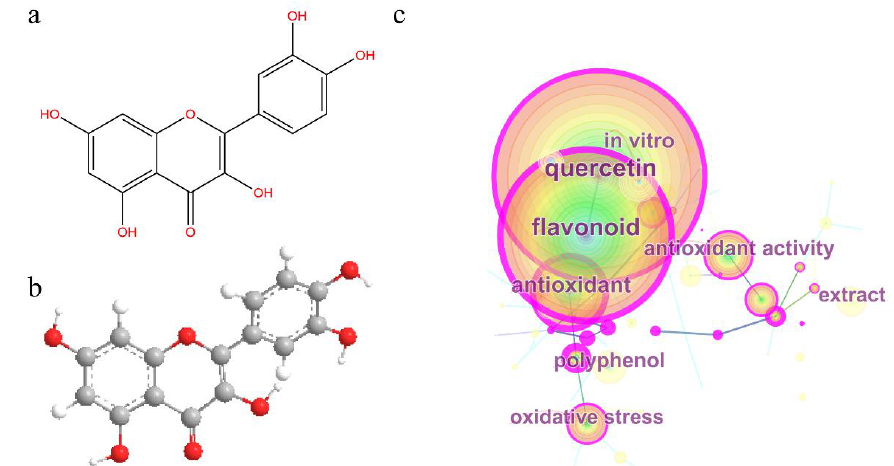
Figure 1. Structure and bibliometric results of quercetin. ( a ) Chemical structure of quercetin. ( b ) 3D conformer of quercetin. ( c ) Co-occurrence map of quercetin. The figure is based on data in the Web of Science (WOS) database ranging from 2000 to 2017, and was drawn by CiteSpace. The diameter of a node represents the number of occurrences of keywords. The larger the diameter, the greater the number of appearances.